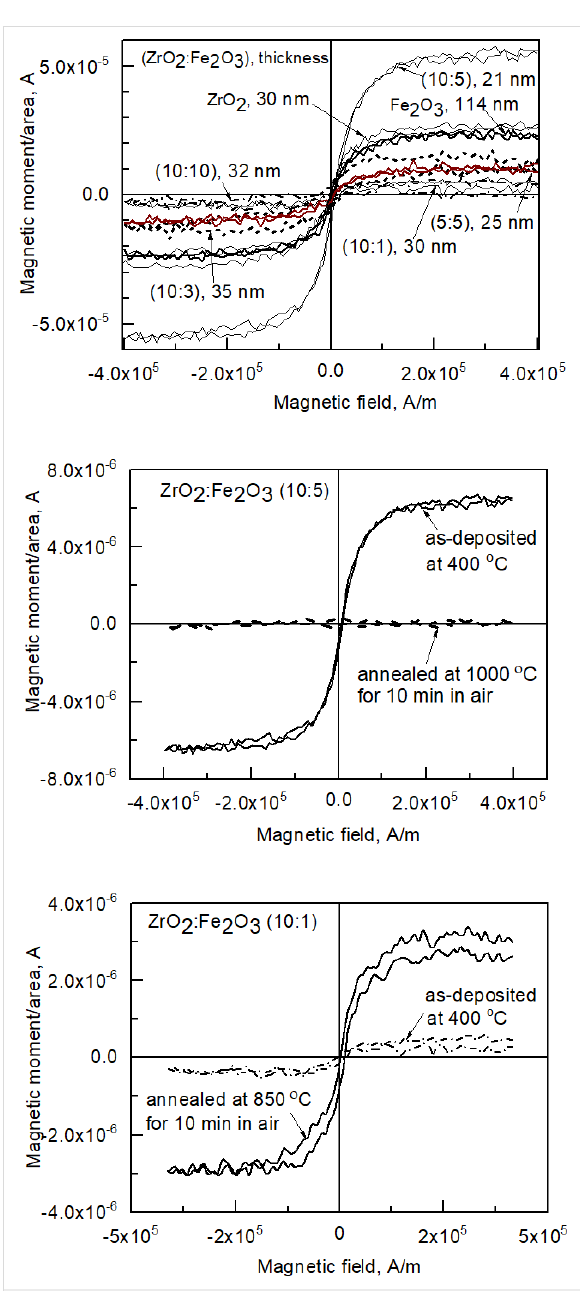
Figure 8: Selected room temperature magnetization–field curves for ZrO 2 /Fe 2 O 3 films. Cycle ratios and thicknesses are indicated in the